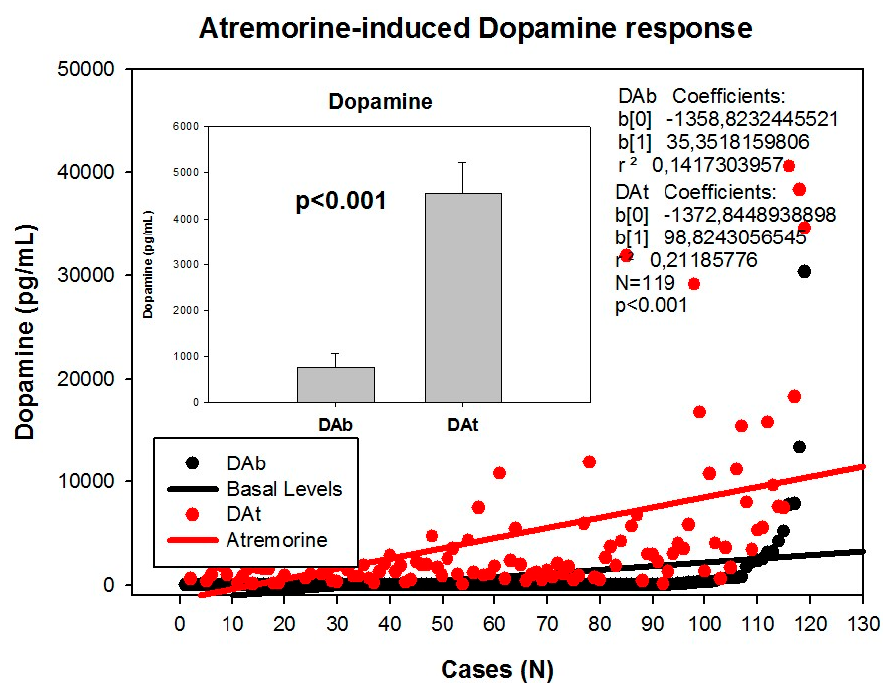
Figure 2. Atremorine-induced dopamine (DA) response in patients with Parkinsonian disorders. DAb: Basal dopamine levels; DAt: Plasma dopamine levels one hour after Atremorine administration (5 g, p.o.). Adapted with permission from Cacabelos et al. [18].